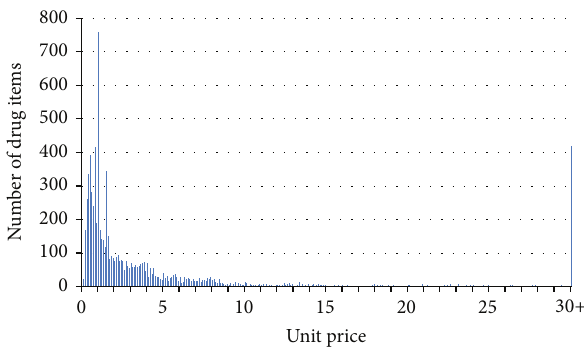
Figure 1: Unit price distribution of oral pills (tablets and capsules) reimbursable within Taiwan’s National Health Insurance in